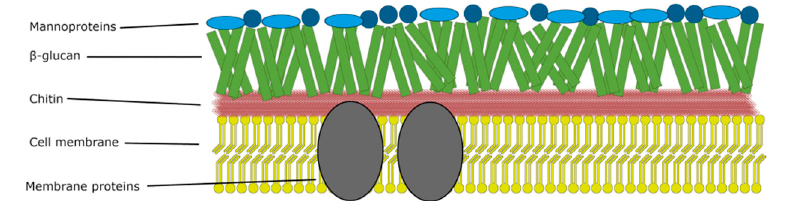
Figure 1. Structure of fungi cell wall.